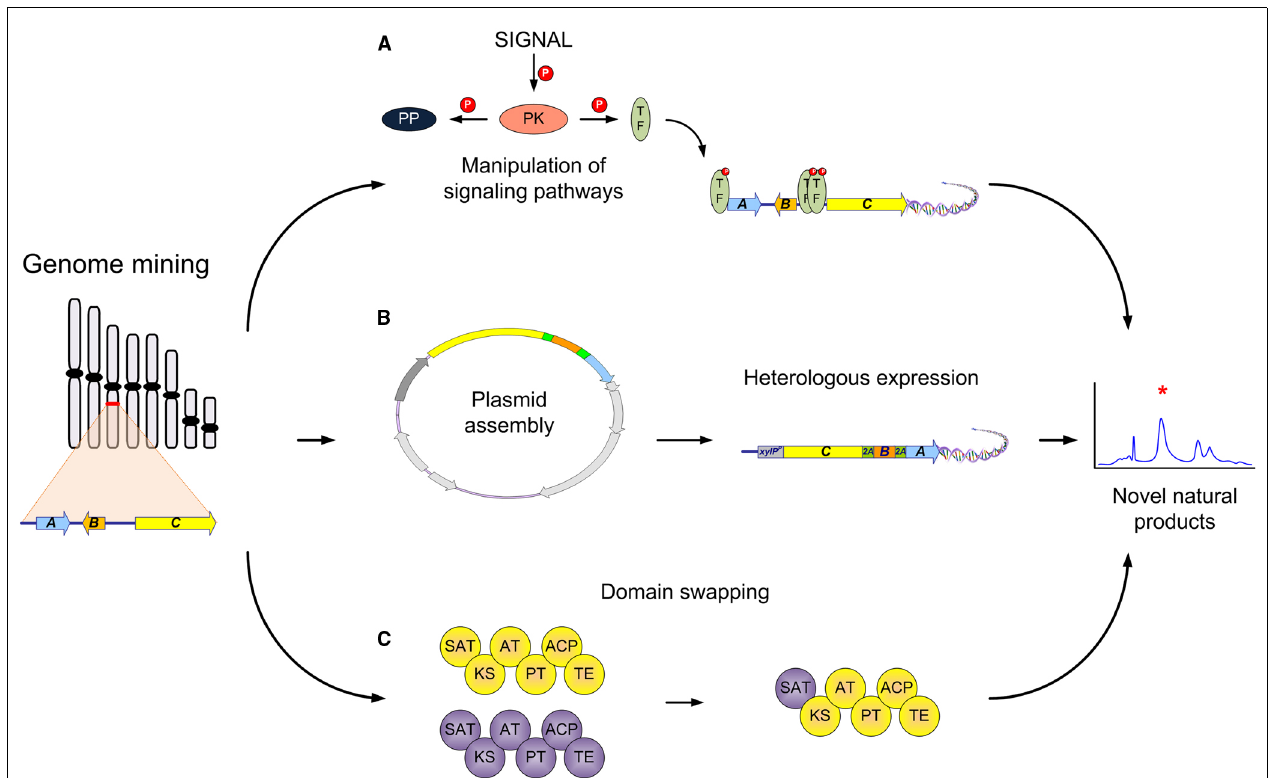
FIGURE 1 | Synthetic biology strategies for natural product production in filamentous fungi. Different strategies that could be used to activate computationally identified gene clusters: (A) Manipulation of different elements of signal transduction pathways leading to novel or different regulation of NPs. The activation (by phosphorylation) of transcription factors (TF), global or NP gene cluster specific, can be achieved by specific stimuli (signal), engineering of protein kinases (PK), or deletion of signal repressors such as protein